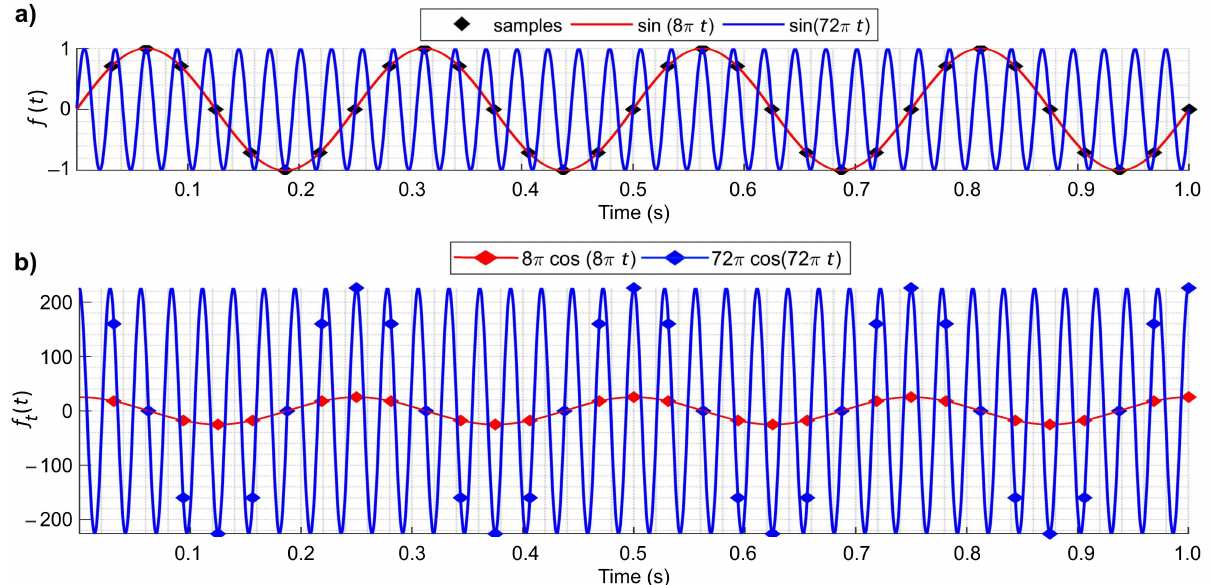
Figure 2. ( a ) Two aliased sinusoids with identical values at sampling frequency 32 Hz, and ( b ) their gradients with many different values at sample